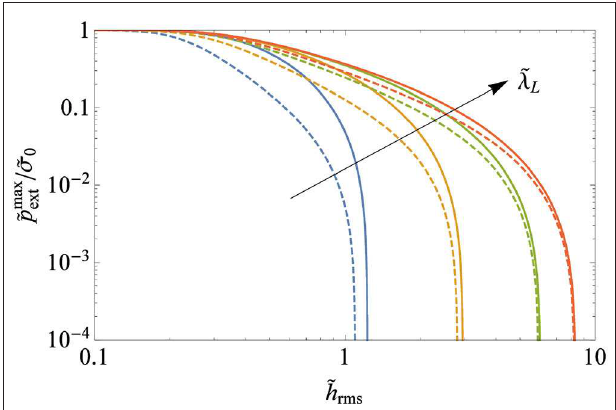
FIGURE 5 | Pull-off mean pressure